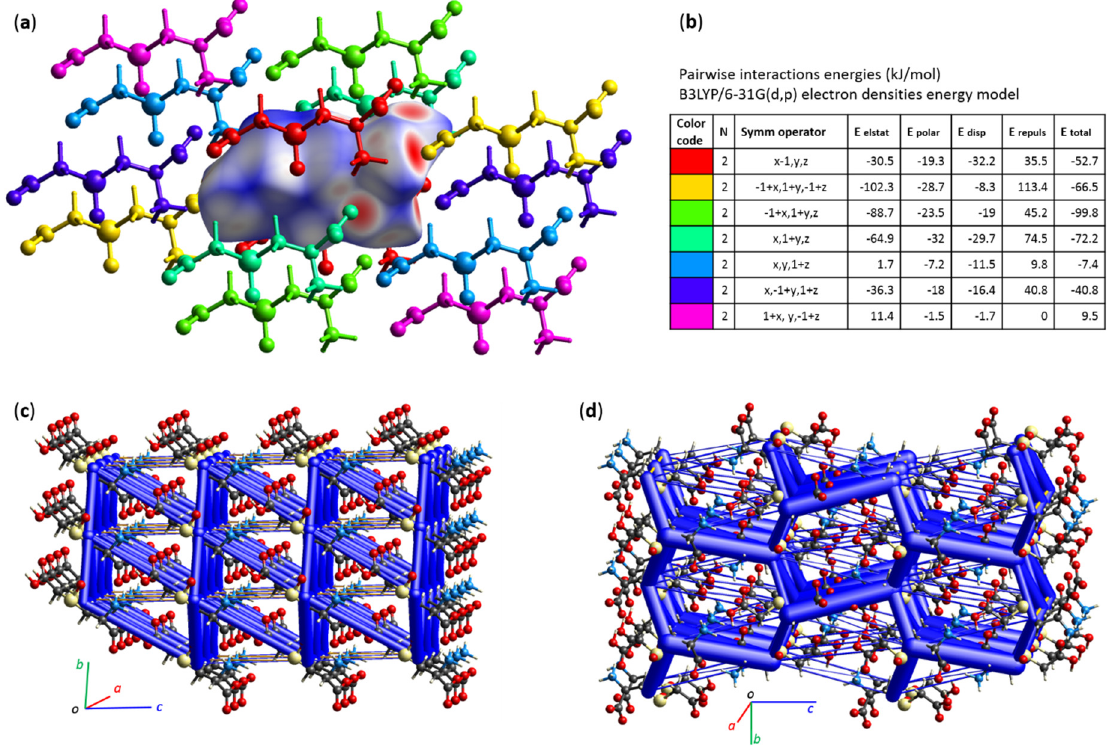
Figure 3. Interaction energies in crystal structures. ( a ) A view of interactions between a central molecule of (4 R )-CMCO in t-(4 R )-CMCO, shown as its Hirshfeld surface, and 14 molecules that share the interaction surfaces with the central molecule. ( b ) Calculated energies (electrostatic, polarization, dispersion, repulsion, and total) of pairwise interactions in t-(4 R )-CMCO between the central molecule and those indicated by respective colors. ( c ) Energy framework for total pairwise interaction energies in t-(4 R )-CMCO. The cylinders link molecular centroids, and the cylinder thickness is proportional to the magnitude of the energies, such as those shown in ( b ). For clarity, the cylinders corresponding to energies < 5 kJ / mol are not shown. ( d ) The total pairwise interaction energy framework in o-(4 R )-CMCO. For interaction energies in o-(4 R )-CMCO and m-(4 S )-CMCO, also see Supplementary Figures S5–S6. For energy frameworks depicting electrostatic and dispersion energies in crystals of CMCO, see Supplementary Figures S7–S9. Table 3. Contributions of intermolecular interactions to the packing energies E (kJ/mol) in crystalline structures of S -carboxymethyl-L-cysteine and its oxidation products.